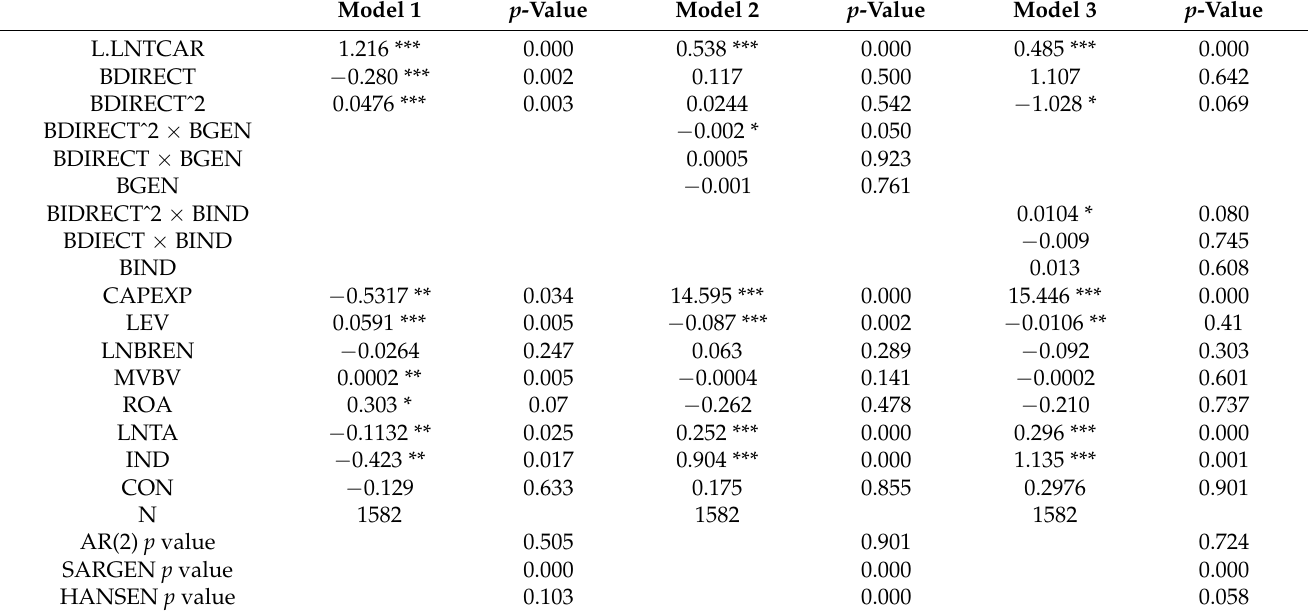
Table 4. Main results: two-step GMM regression for Models 1, 2, and